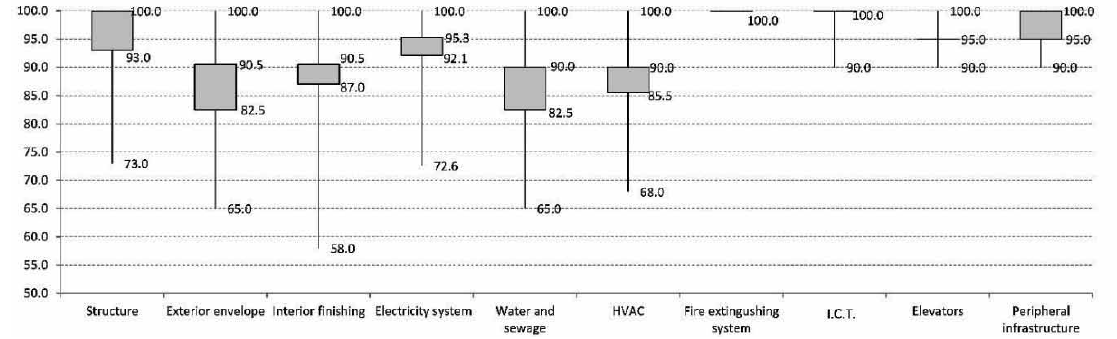
Fig. 6. Minimum, maximum, second and third quartile value of performance for each system